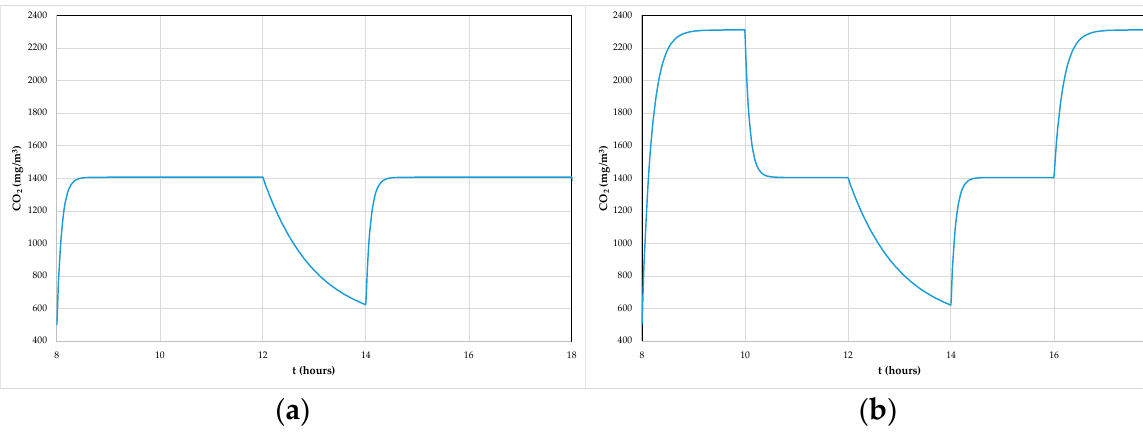
Figure 8. Evaluation of carbon dioxide (CO 2 ) concentration for Case C ( a ) and Case D ( b ).